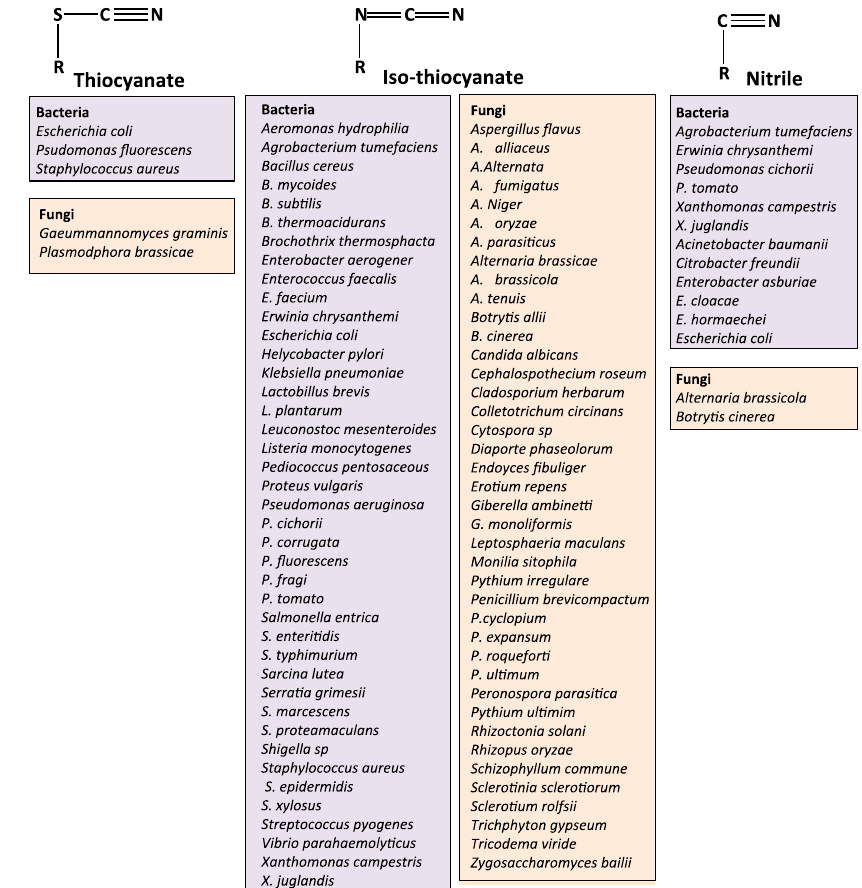
Figure 3. The antimicrobial activities of glucosinolate thiocyanate, iso-thiocyanate and nitrile derivatives.